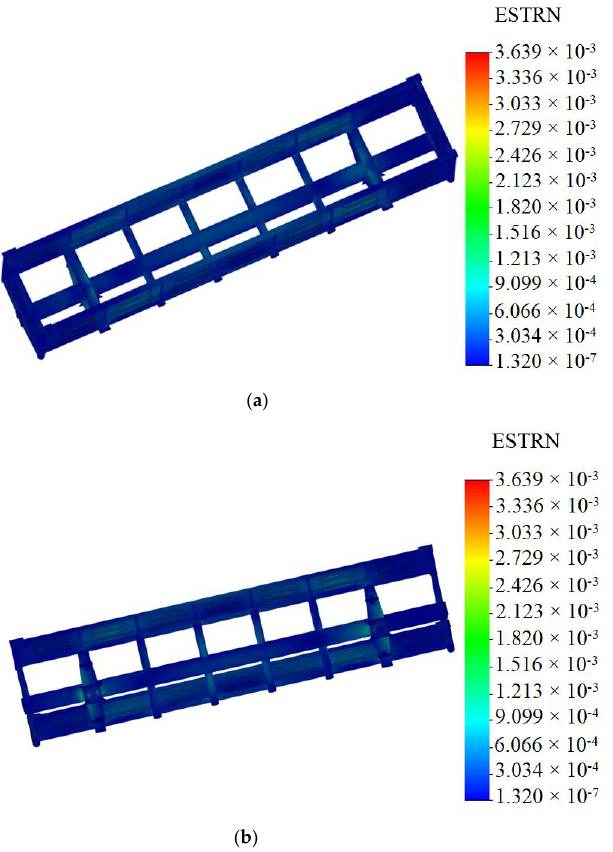
Figure 6. Displacements in assembly units of carrying structure of open wagon ( a ) top view; ( b ) bottom view.